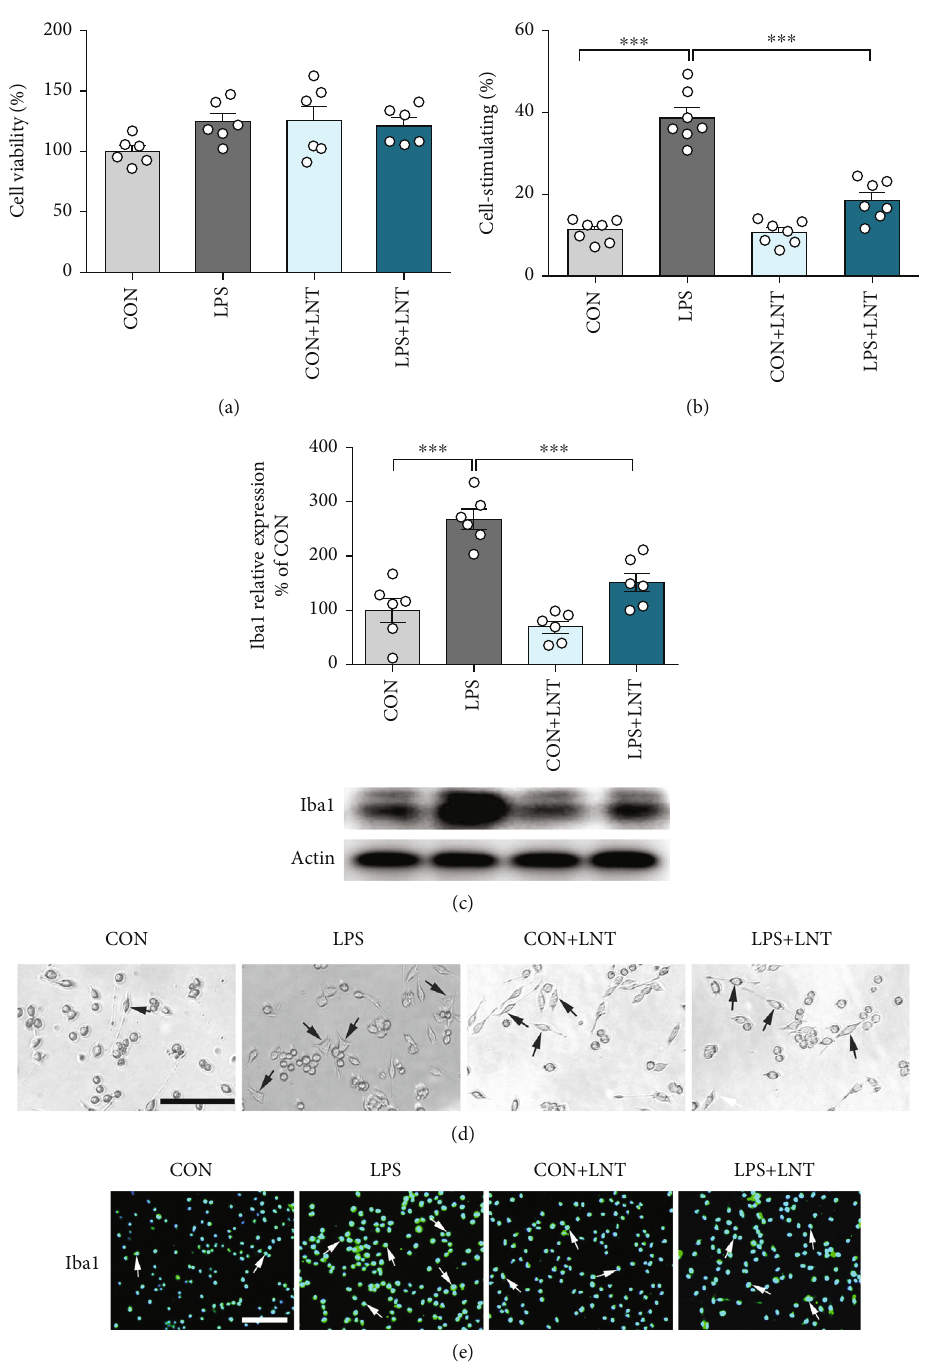
Figure 1: LNT inhibited LPS-induced activation of BV2 cells. The proliferation rate (percentage of control) of BV2 cells was measured by CCK-8 assay. (a) BV2 cells were treated with LNT (400 μ g/ml), LPS (1 μ g/ml), and LNT (400 μ g/ml) with LPS (400 μ g/ml) for 24 h. (b) The graph represents the quanti fi cation of activated BV2 cells. (c) The protein levels of Iba1 were detected by Western blotting. (d) Typical morphological features of cells were detected by microscopy. (e) Representative immunostaining showing the distribution of Iba1 in the experimental groups. Black or white arrows indicate representative cells in the treatment group. All data are presented as the mean ± SEM . Scale bar = 50 μ m (d); scale bar = 100 μ m (e). Statistical analysis was performed using one-way ANOVA followed by the post hoc Tukey tests. ( ∗ P < 0 : 05 , ∗∗ P < 0 : 01 , and ∗∗∗ P < 0 : 001